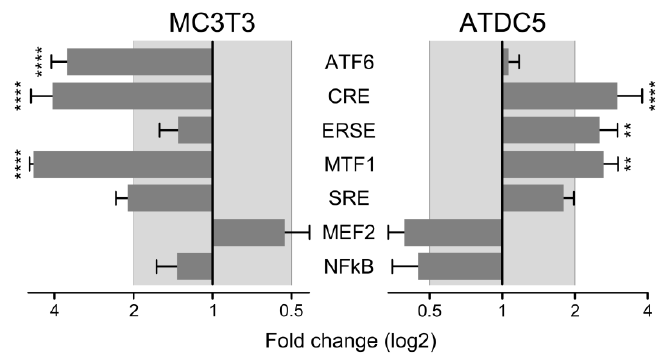
Figure 3. Activity of signaling pathways altered upon exposure of mineralogenic cell lines MC3T3-E1 and ATDC5 to cadmium chloride. Signaling activities were inferred from firefly and Renilla luciferase activities measured in cells reverse-transfected by reporter constructs of the CIGNAL 45-pathway array and exposed to water (vehicle) or 1 μ M of cadmium chloride. Results are presented as fold changes of luciferase values in treated versus control cells. Asterisks indicate values statistically different according to one-way ANOVA followed by Dunnett’s multiple comparison test (** p < 0.01; **** p < 0.0001); Values are presented as the mean ± standard deviation (n = 3).